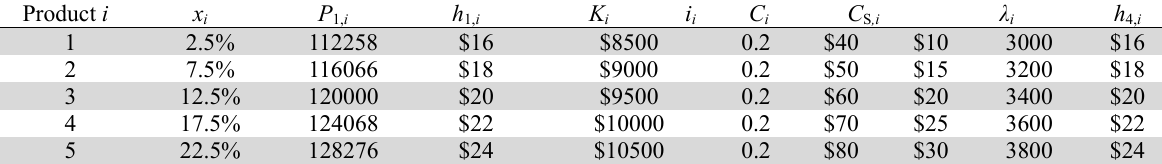
The assumed parameters’ values in the second manufacturing stage